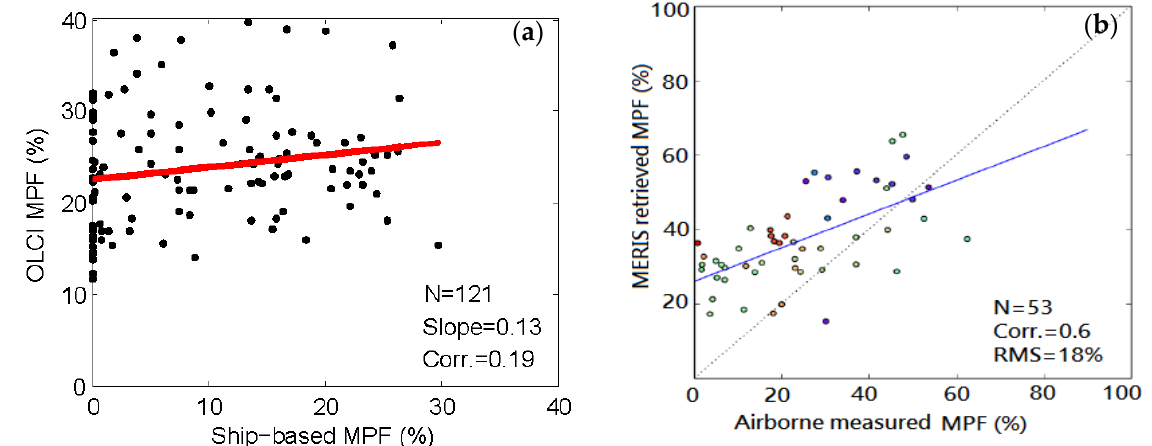
Figure 12. ( a ) Scatter plot of the daily mean satellite-retrieved OLCI MPF versus the ship-based MPF during 2017–2020. The red lines are the corresponding linear fits. ( b ) Scatter plot of the MERIS retrieved MPF versus the airborne measured MPF for 7 June 2008, adopted from a previous study [34].